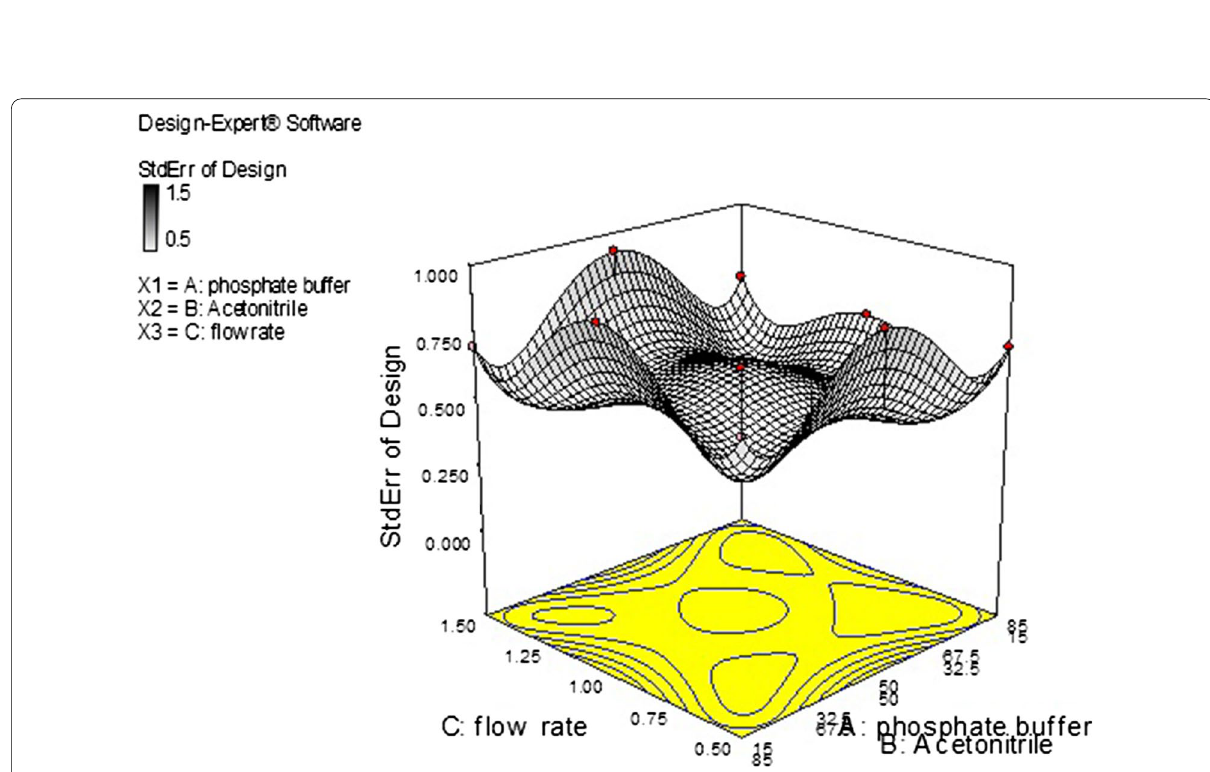
Fig. 5 3D surface plots of the standard error